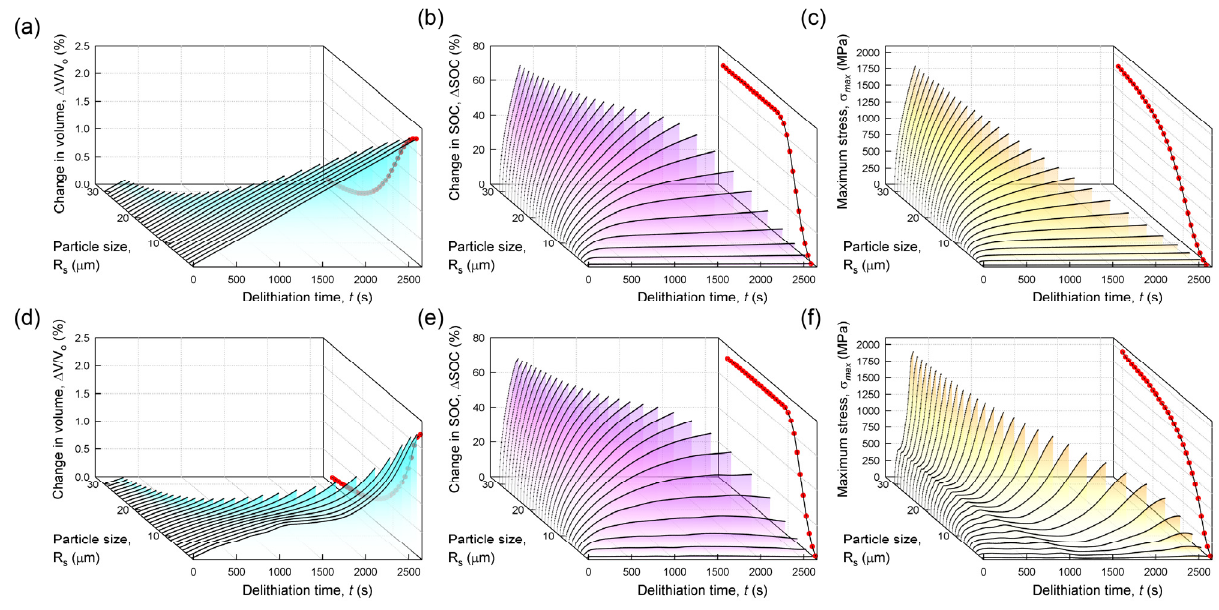
Figure 9. Impact of particle size (R s ) on the transient chemomechanical response during the delithi- ation process. The results ( a – c ) were obtained using a constant partial molar volume, and the results ( d – f ) were obtained using a variable partial molar volume. The red dots to the right of each graph denote the evolution of the peak values with respect to the particle size increase. ( a , d ) Evolution of the volume change ( ∆ V/V o ) of particle size. ( b , e ) Evolution of the maximum difference in this state of charge ( ΔSOC ). ( c , f ) Evolution of the first principle maximum stress ( 𝜎 (cid:3040)(cid:3028)(cid:3051) ) in the active particle. Meanwhile, as the concentration gradients increase, 𝜎 (cid:3040)(cid:3028)(cid:3051) also increases, as shown